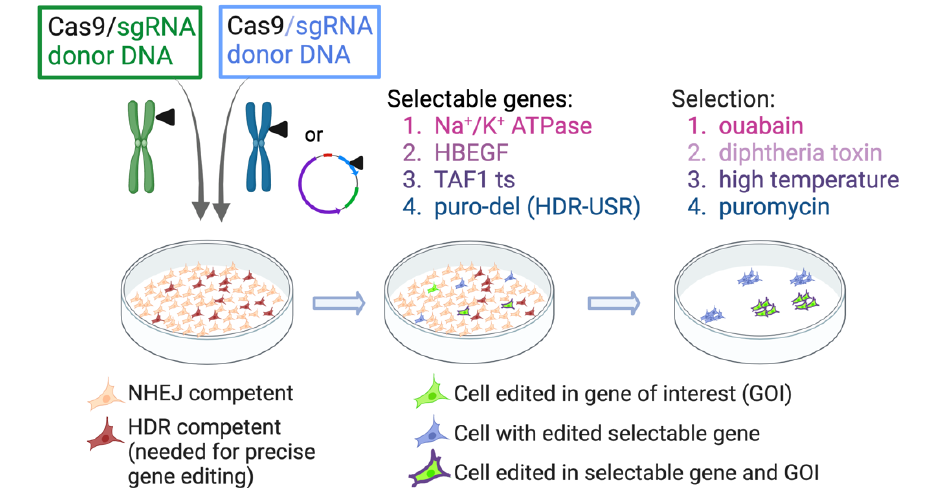
Figure 5. Co-editing an endogenous or plasmid-encoded selectable gene. Cells are transfected with Cas9/donor for the GOI, in addition to Cas9/donor for an endogenous gene, or with the HDR-USR reporter plasmid. The co-edited genes provide resistance to selection, and as the genomic perturbations are minimal, these methods are scarless or semi-scarless. Created with BioRender.com.